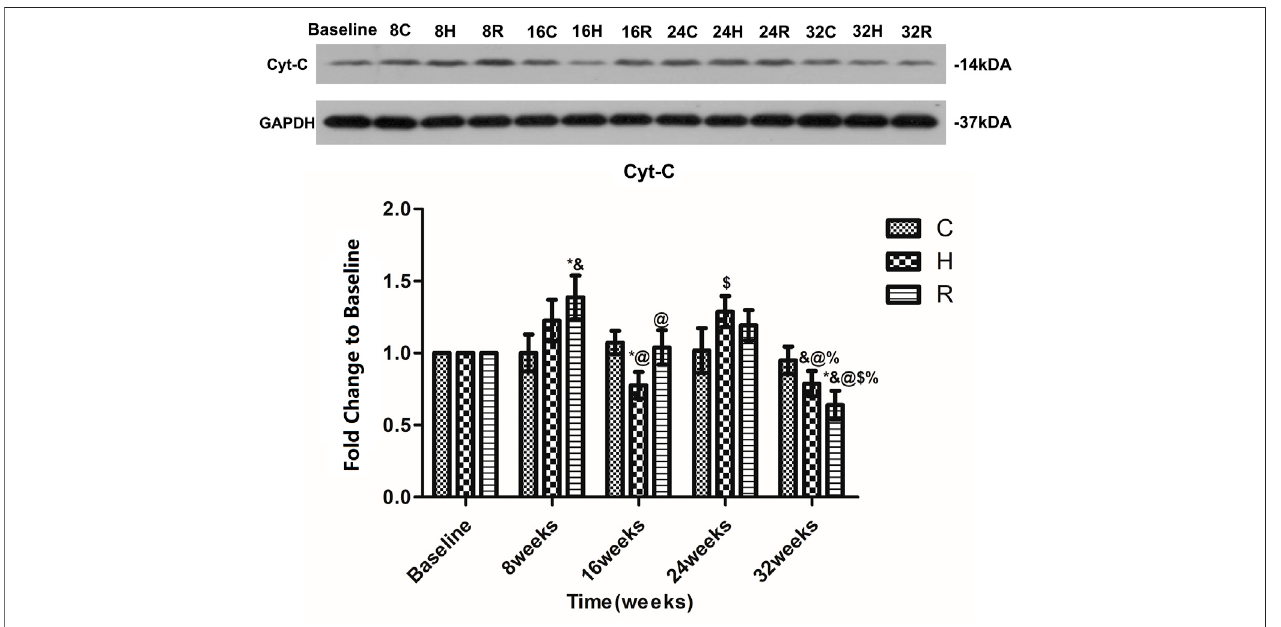
FIGURE 7 | Age and exercise training effects on Cyt-3 levels in mitochondria of soleus muscle, were evaluated by Western blot. * Signi fi cant different from C and othergroup;&Signi fi cantdifferentfromBaseline andotherweeks;@Signi fi cantdifferentfrom8 weeksandotherweeks;$Signi fi cantdifferentfrom16 weeksandother weeks; % Signi fi cant different from 24 weeks and other weeks. ( p < 0.05).